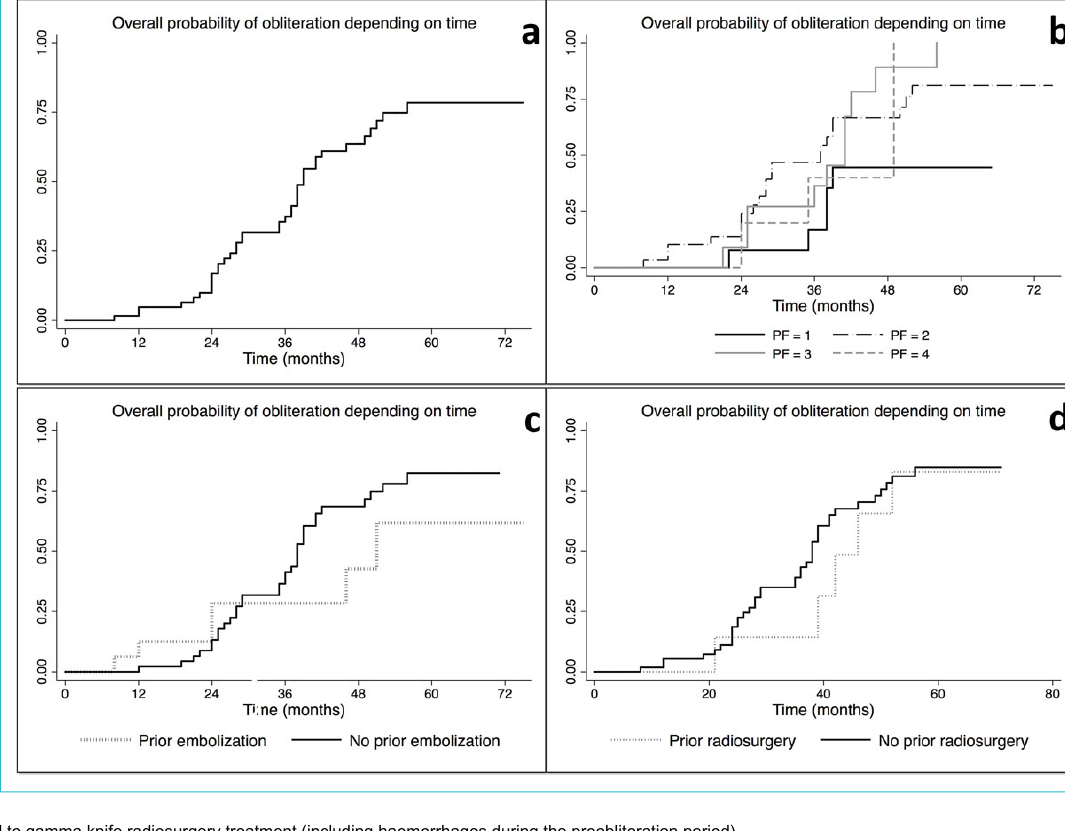
Table 4: Complications related to gamma knife radiosurgery treatment (including haemorrhages during the preobliteration period). Type of